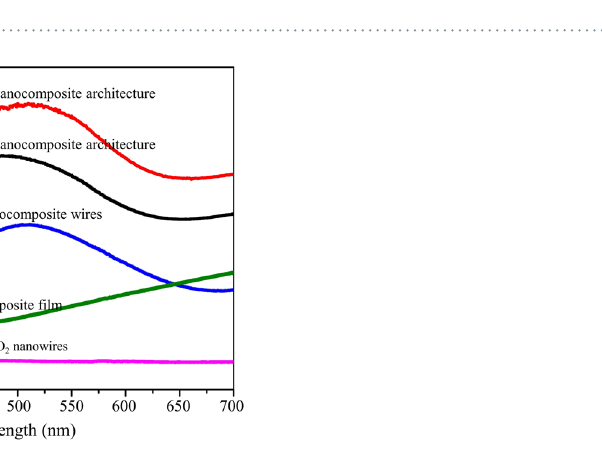
Table 1. The compositions of Ag/TiO 2 nanocomposite cross architecture obtained by XPS at specified etching times.